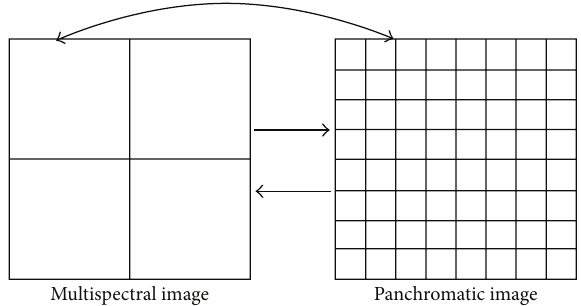
Figure 2: The spatial mapping relationship between multispectral and panchromatic images, taking a resolution rate of 1:4 for